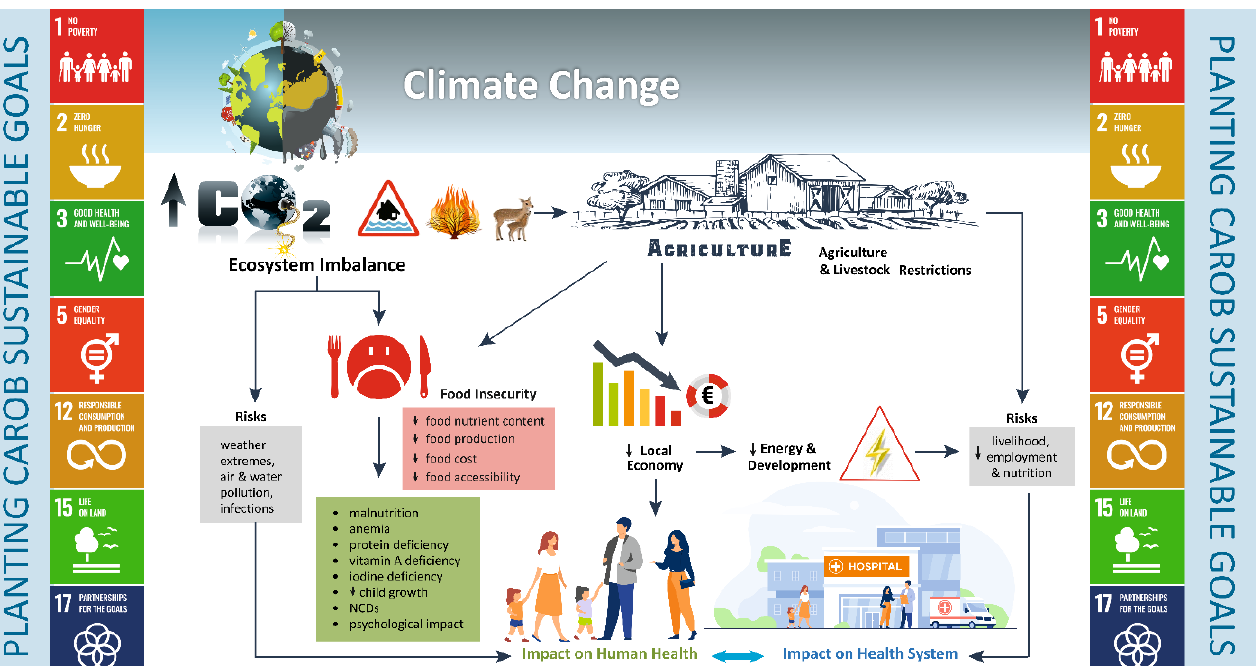
Figure 2. Interplay between climate change, food security, nutrition and human health. Planting carob trees might be a promising course of action to achieve the following sustainable development goals (SDGs) across the Mediterranean area: SDG1, to eradicate extreme poverty; SDG2, to end poverty; SDG3, to achieve good health and well-being; SDG5 to empower women in economic life; SDG12, for the responsible consumption and production; SDG15, for protecting, restoring and promoting the sustainable use of terrestrial ecosystems and reversing land degradation; and SDG17, for partnerships to achieve the